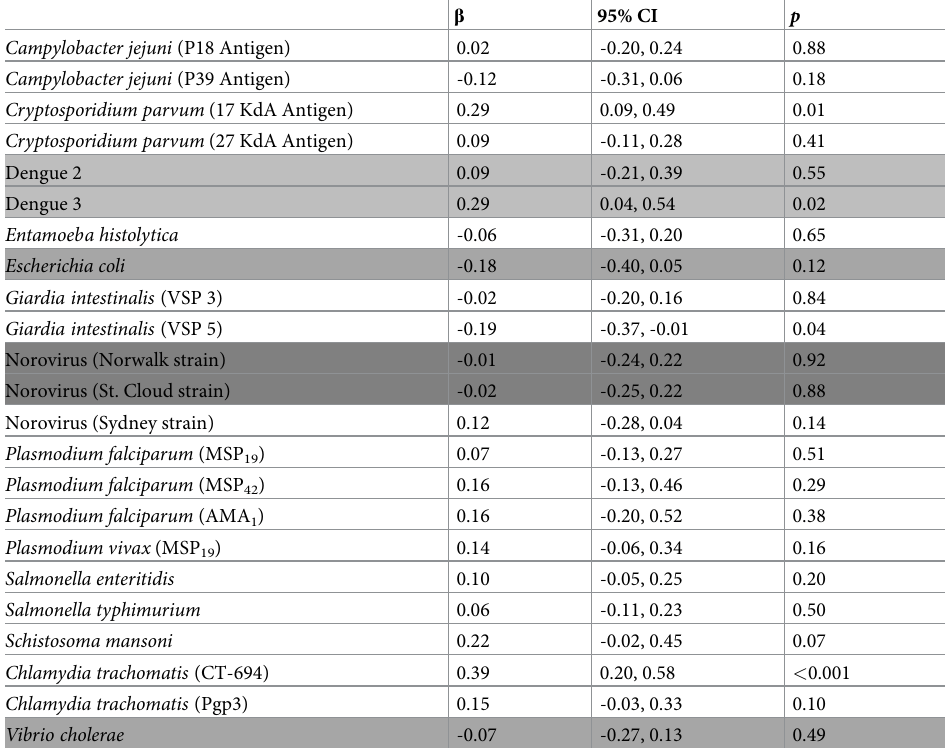
Models control for pupil age, grade, and household access to WASH, and include a random intercept for school Shaded rows represent antigens included in the final linear latent model Due to the Bonferroni correction for multiple comparisons, p < 0.002 is considered statistically